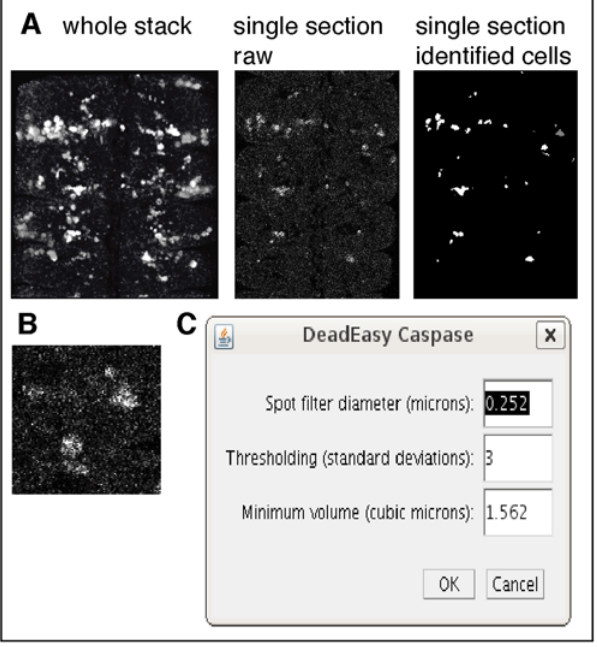
Figure 3. DeadEasy Caspase: the mathematical algorithm. DeadEasy Caspase detects apoptotic cells in embryos stained with anti-cleaved- Caspase-3, and are characterised by low cytoplasmic signal, high background and volume $ 1.56 m m 3 . (A) Diagram showing the region of the embryonic VNC (blue) scanned for counting. (B) Caspase histogram. (C) Enlarged images to compare a raw image vs. the result (single confocal 0.25 m m slices shown). (D) Diagram of the algorithm. (E) Images showing the different steps of processing, correlating with each step in the diagram in (D). (F) Examples of bad quality stainings or images that must not be used for cell counting as they will produce false positives.